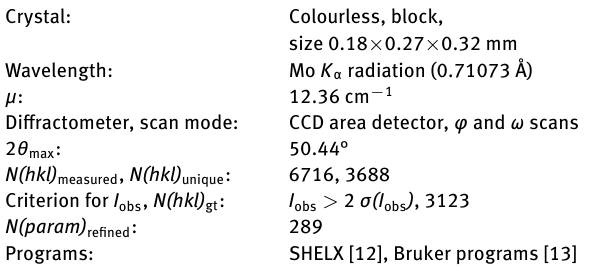
Table 2: Fractional atomic coordinates and isotropic or